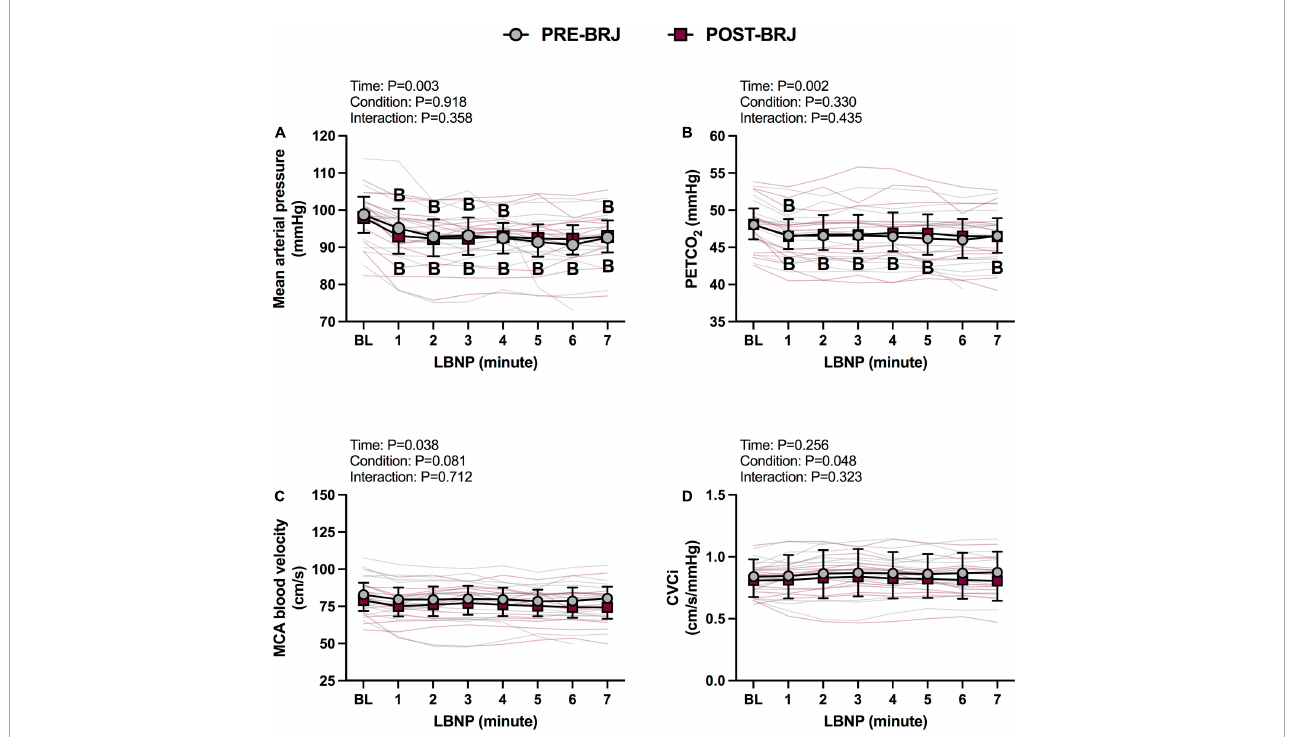
FIGURE5 Individual responses and absolute means with 95% confidence intervals for mean arterial pressure (A) , end-tidal CO 2 tension (B) , middle cerebral artery blood velocity (C) , and cerebrovascular conductance index (D) at the last minute of baseline (BL) and during every minute of static lower-body negative pressure (LBNP; –40 mmHg) before (PRE–BRJ) and 3 h after beetroot juice consumption (POST–BRJ). Linear mixed-effect models were used to compare mean values within a given variable. Post-hoc tests using the Bonferroni’s correction for multiple comparisons were used where appropriate. B = different from baseline ( P ≤